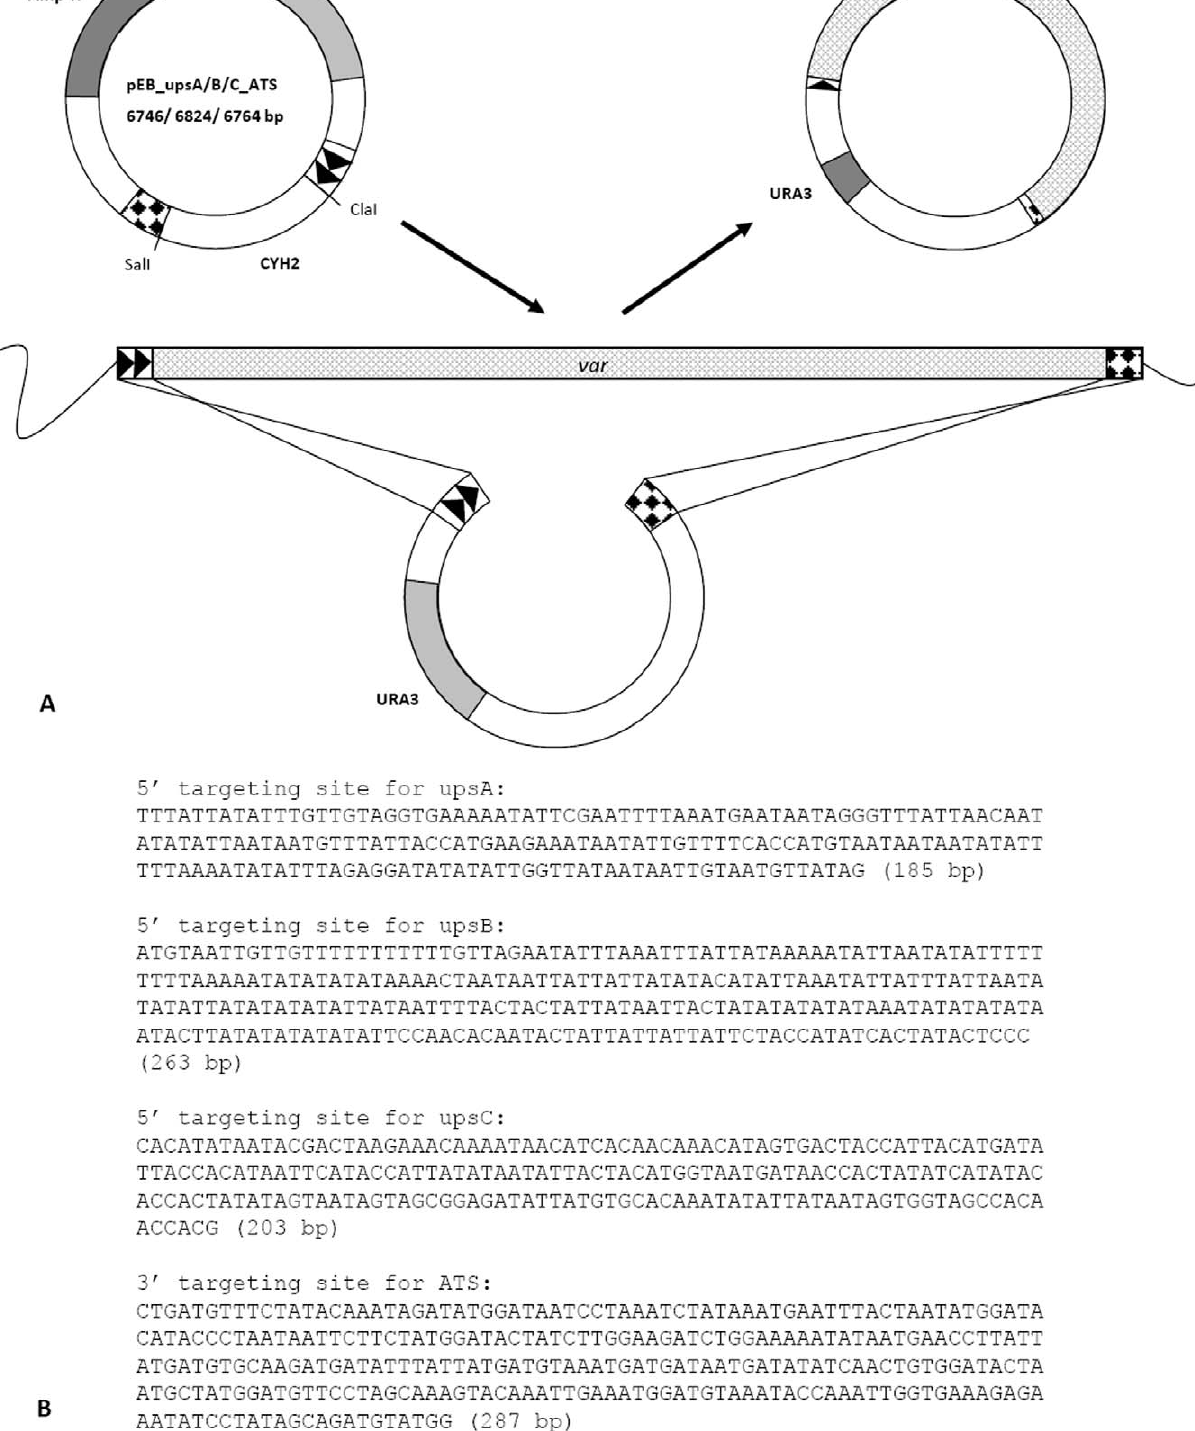
Figure 1. Construction of the var TAR vectors. (A) TAR cloning vectors pEB_upsA/B or C_ATS were constructed from the general TAR vector pEB2 (M. Becker and E.J. Louis, unpubl.). The 5 9 targeting sites upsA (185 bp), upsB (263 bp) or upsC (203 bp) are indicated by black arrows. The 3 9 targeting site is identical in all three TAR cloning vectors and contains part of the ATS region (287 bp) indicated with black squares. The yeast centromere and ARS are labelled as CEN and ARS, the positive selectable marker gene URA3 is indicated as light grey box (URA3), the negative selectable marker CYH2 with a white box (CYH2), and the Ampicillin resistance gene with a dark grey box (Amp-R). SalI and ClaI restriction sites are indicated. Homologous recombination between the targeting sites and P. falciparum genomic DNA results in the cloning of a var gene flanked by those sites as a circular molecule. (B) 5 9 and 3 9 targeting sequences used in the TAR cloning vectors pEB_upsA/B or C_ATS. doi:10.1371/journal.pone.0017782.g001 PLoS ONE | www.plosone.org